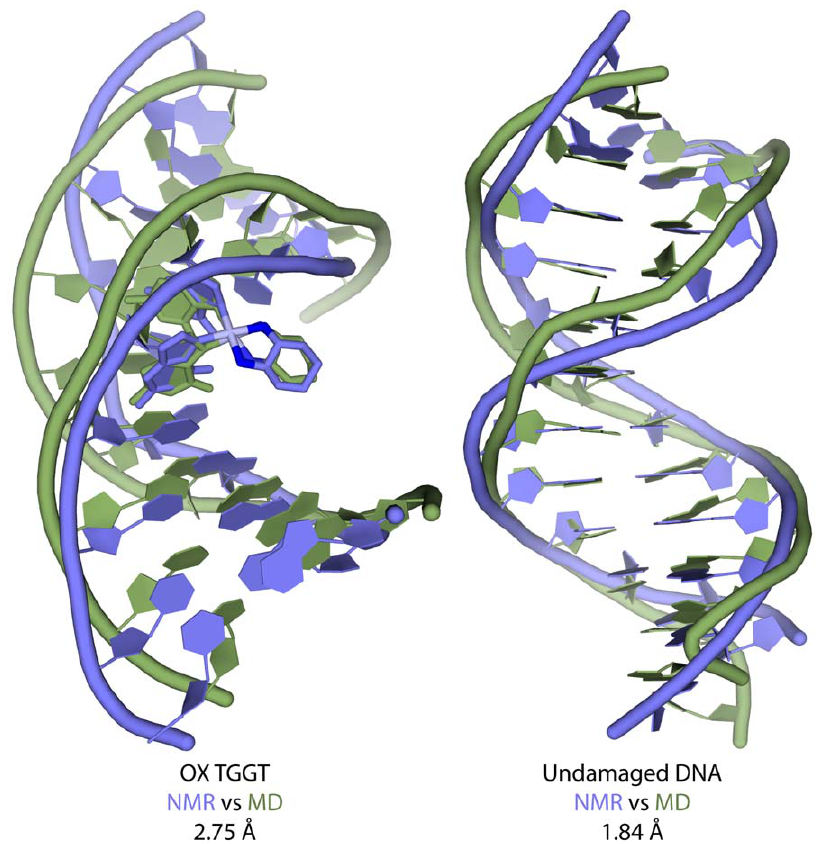
Figure 6. Comparison of NMR average structures and MD centroid structures. Structural alignment of the NMR average structures and MD centroid structures using only the atoms from the DNA part of OX-DNA (left) and undamaged DNA (right).